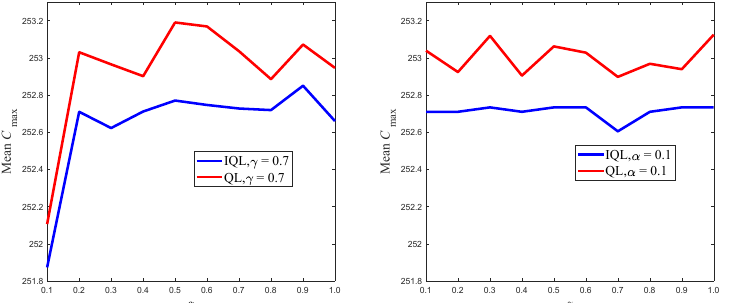
Figure 3. Comparison of impacts on average finishing time of different parameters, before and after the improvement.